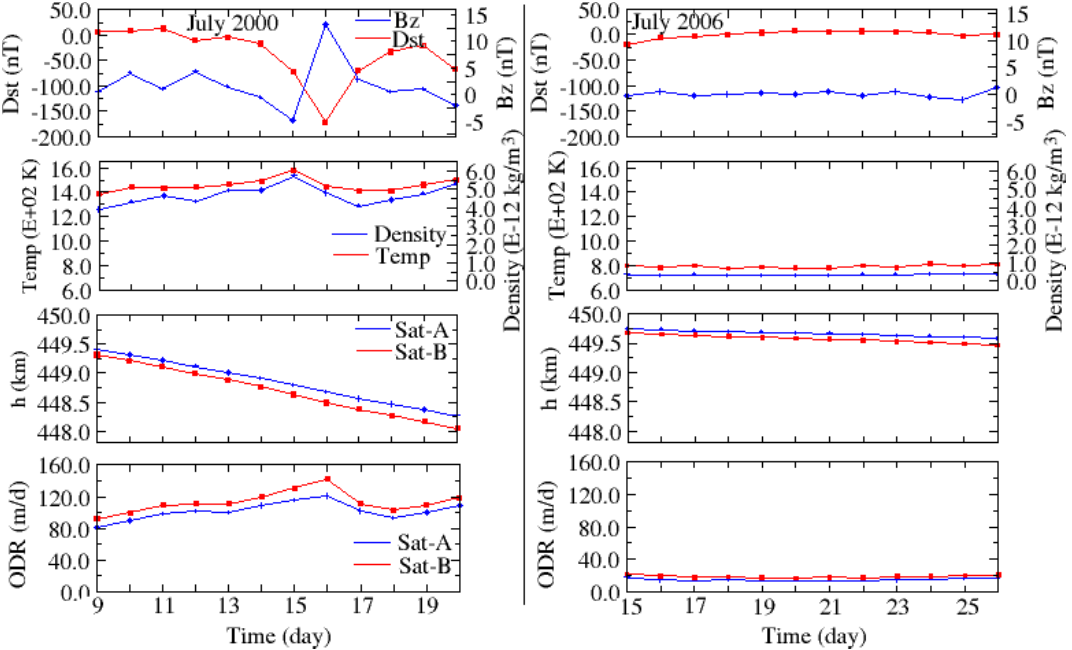
Figure 11. Corresponding mean daily variations in Dst, B z , ρ , T , h and ODR for Sat-A and Sat-B during 9–20 July 2000 (left) and 15– 26 July 2006